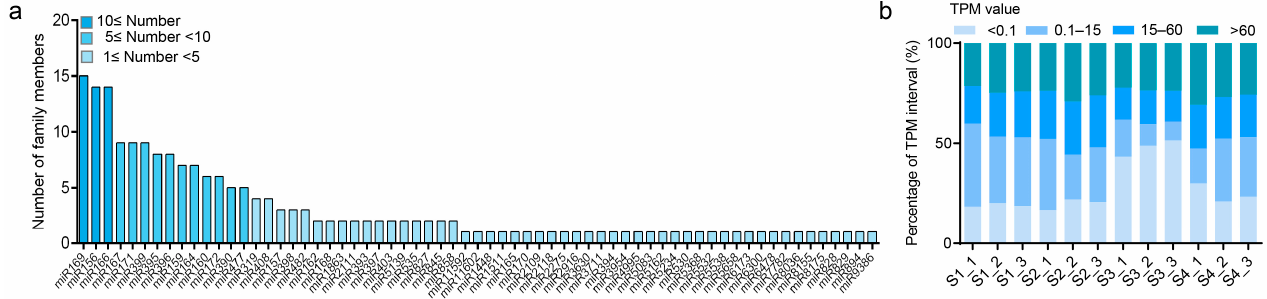
Figure 7. Characteristics of the identified miRNAs. ( a ) The number of family members of identified miRNAs. ( b ) The percentage of TPM intervals of identified miRNAs in twelve sRNA libraries.